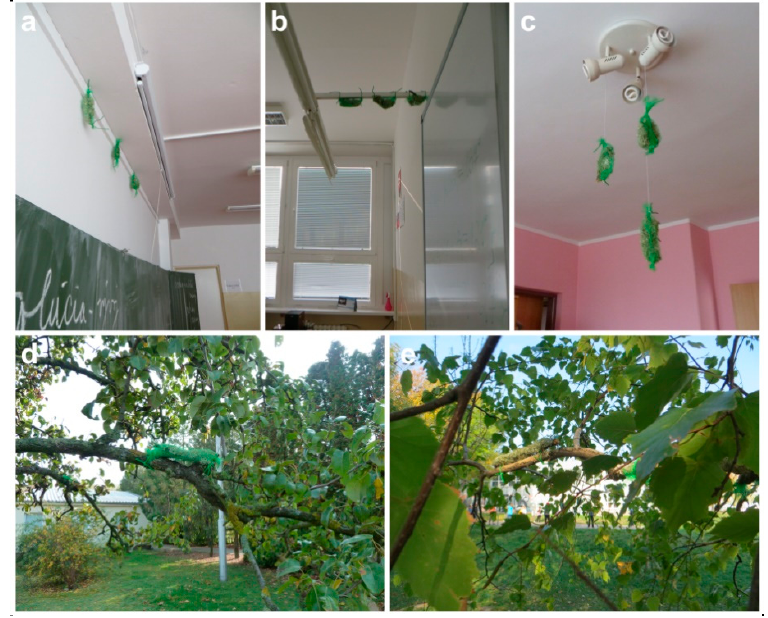
Figure 2. Lichen transplants ( Evernia prunastri ) exposed: ( a, b, c ) indoors; ( d, e ) outdoors.